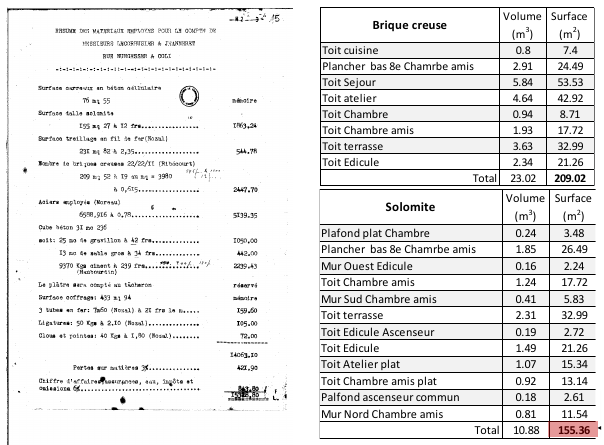
Figure 9. Parallel between materials paid by Le Corbusier and quantities exported from the 3D